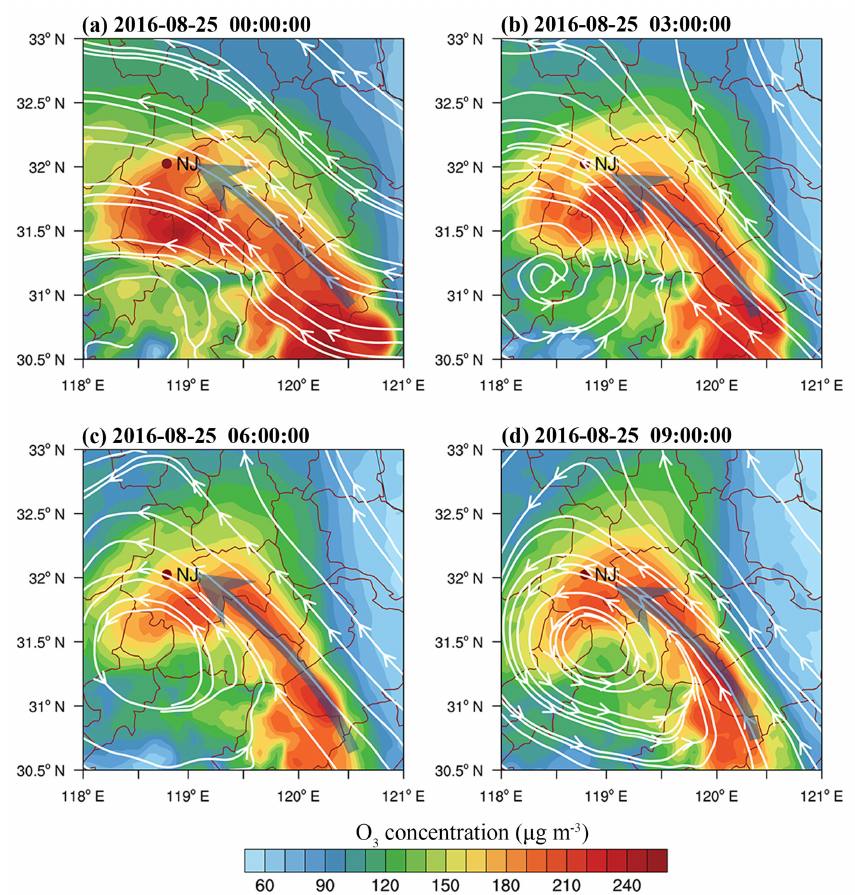
Figure 5. The spatial distribution of O 3 concentrations and wind streamlines at a height of about 900m at (a) 00:00, (b) 03:00, (c) 06:00 and (d) 09:00 on 25 August 2016. The blue thick lines with arrows represent the major regional O 3 transport routes from the eastern to the western